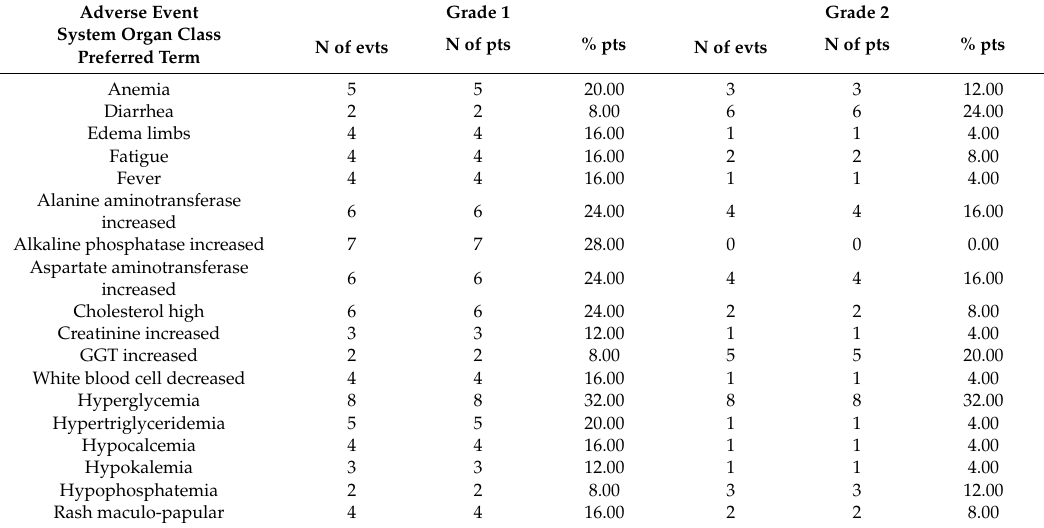
Table 3. Grade 1 and 2 adverse events occurring in more than 10% of the safety population. Adverse Event